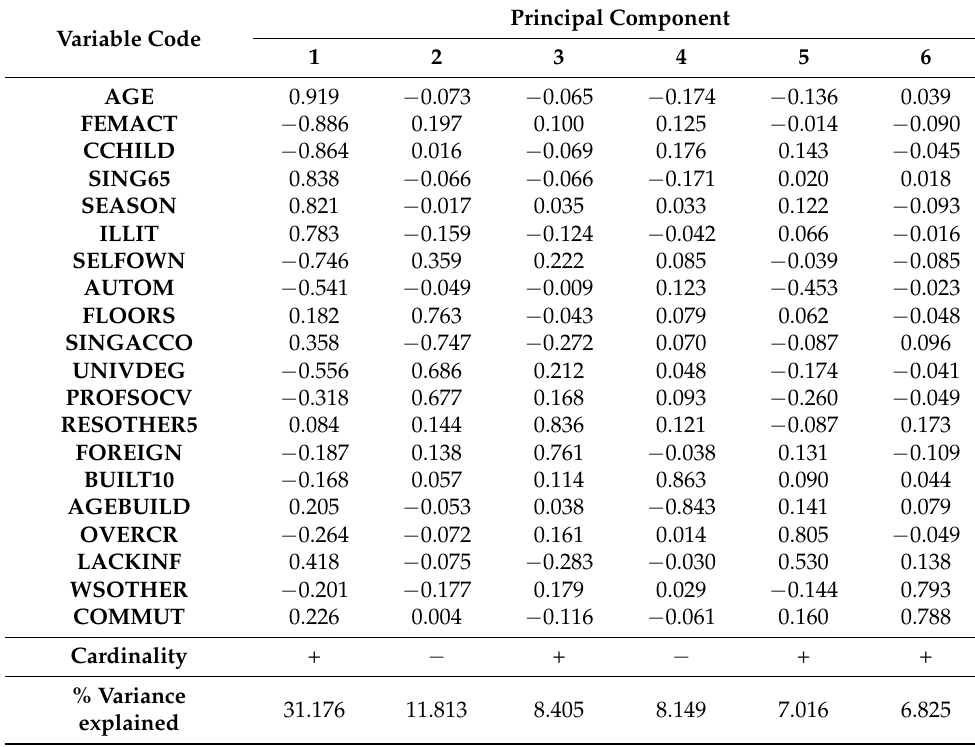
Table 4. Loadings, cardinality and percentage of variance explained for the 6 principal components extracted to express criticality. Loading values ≥ 0.4 or ≤− 0.4 are highlighted in grey. The total percentage of variance explained was 73.38%.